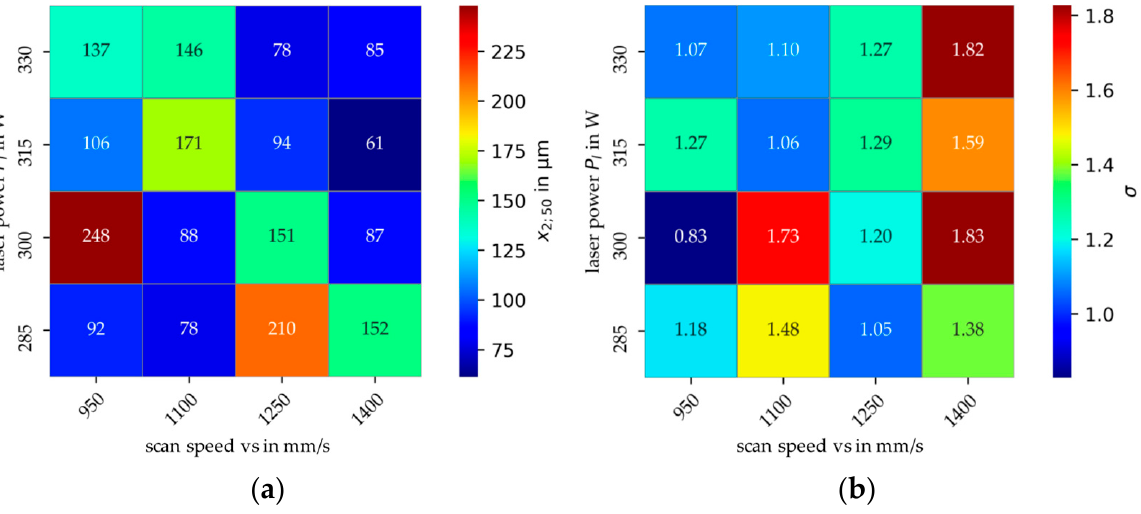
Figure 4. ( a ) Area median diameter pore-size distribution, ( b ) span σ = (d 90 − d 10 )/d 50 of distribution. A large pore diameter with a small span value means that the porosity is governed by large pores, which is very critical regarding material properties. In this case, there are many with a large span value result in a wide distribtion with few large pores.